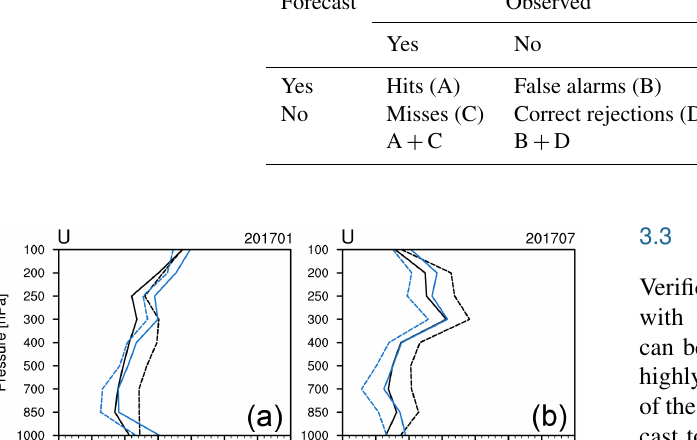
Table 4. The 2 × 2 contingency table for dichotomous (yes–no) events. Forecast